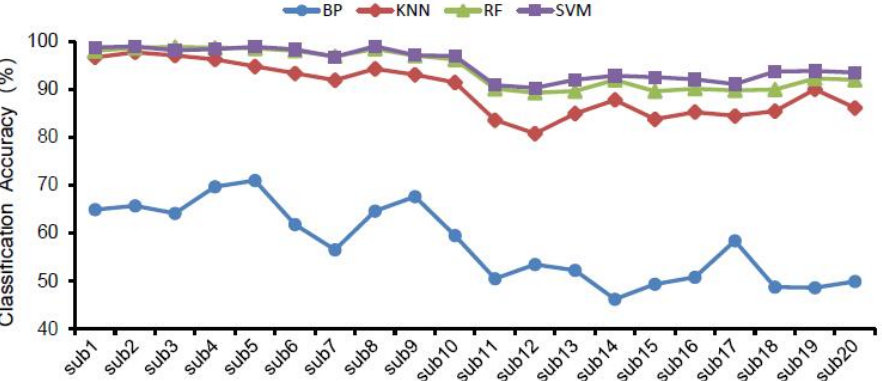
Figure 5. The highest classification accuracy of different classifiers in all bands in 20 subjects.